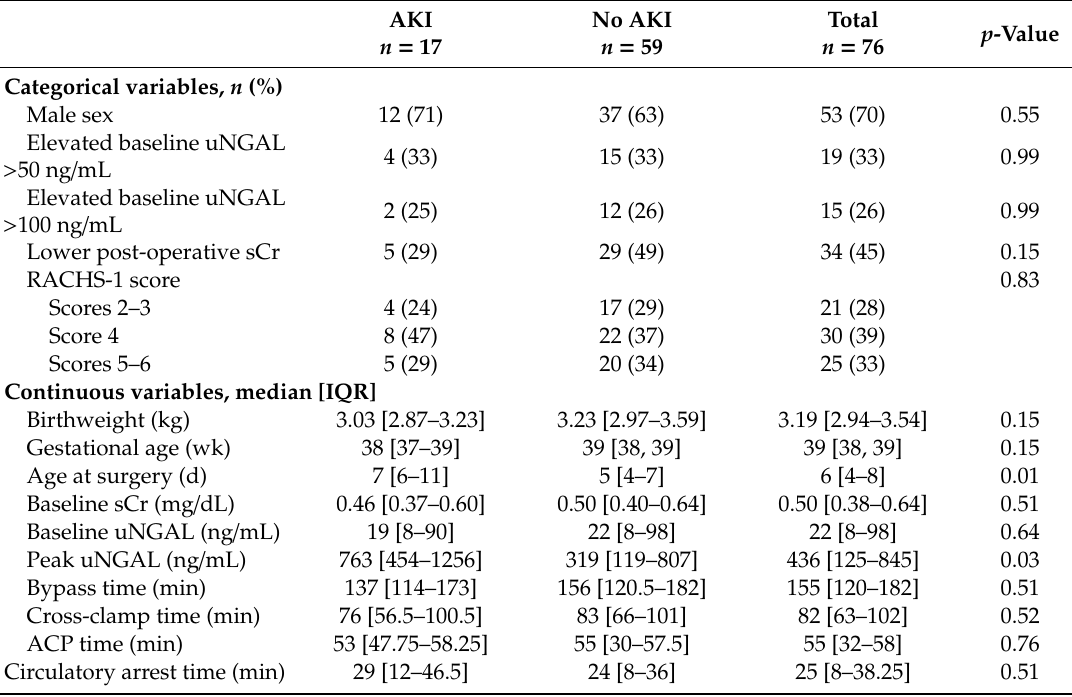
Table 1. Characteristics of study sample by AKI